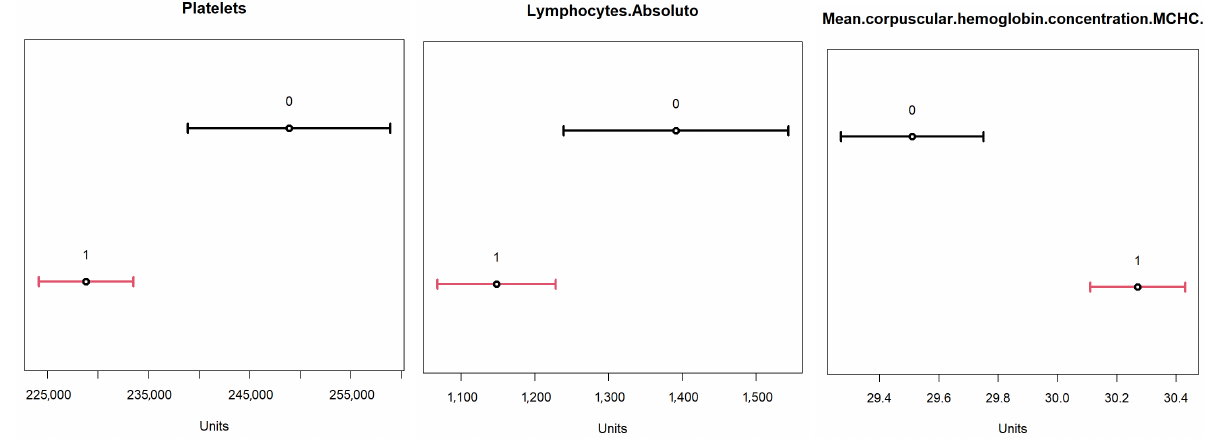
Figure 20. 95% confidence intervals of the variables identified at level 2— TESSOM .